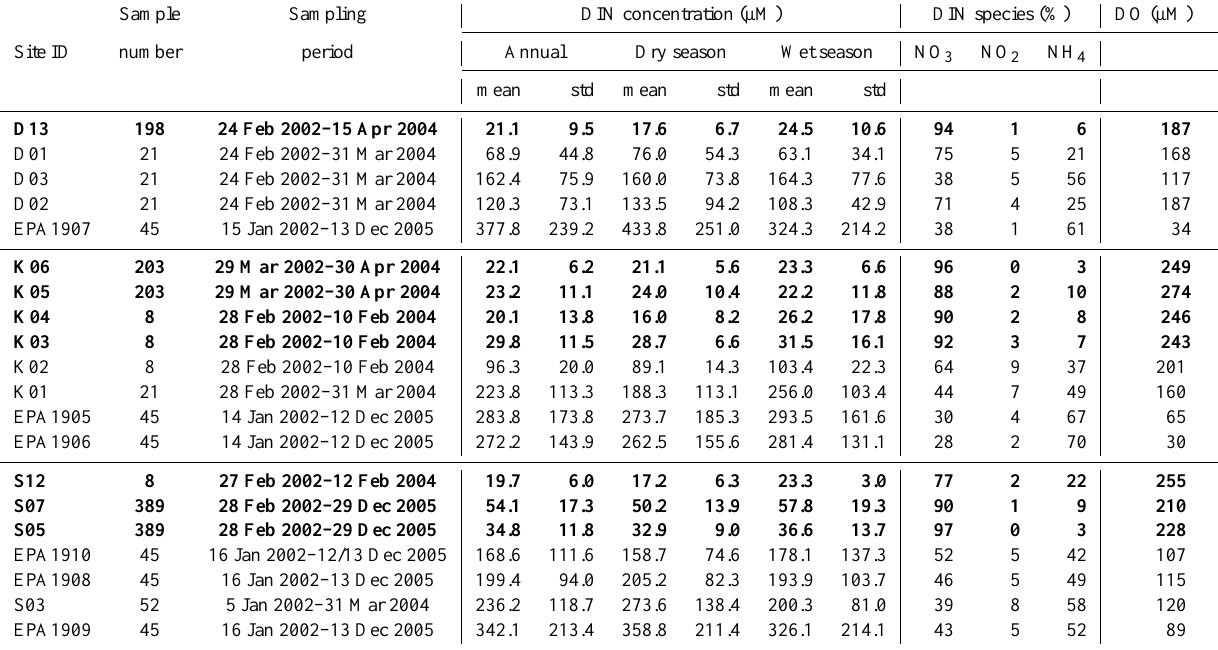
Table 2. Observed dissolved oxygen (DO), DIN concentrations, compositions of DIN species and their corresponding sample numbers and sampling periods. Upstream sites are in